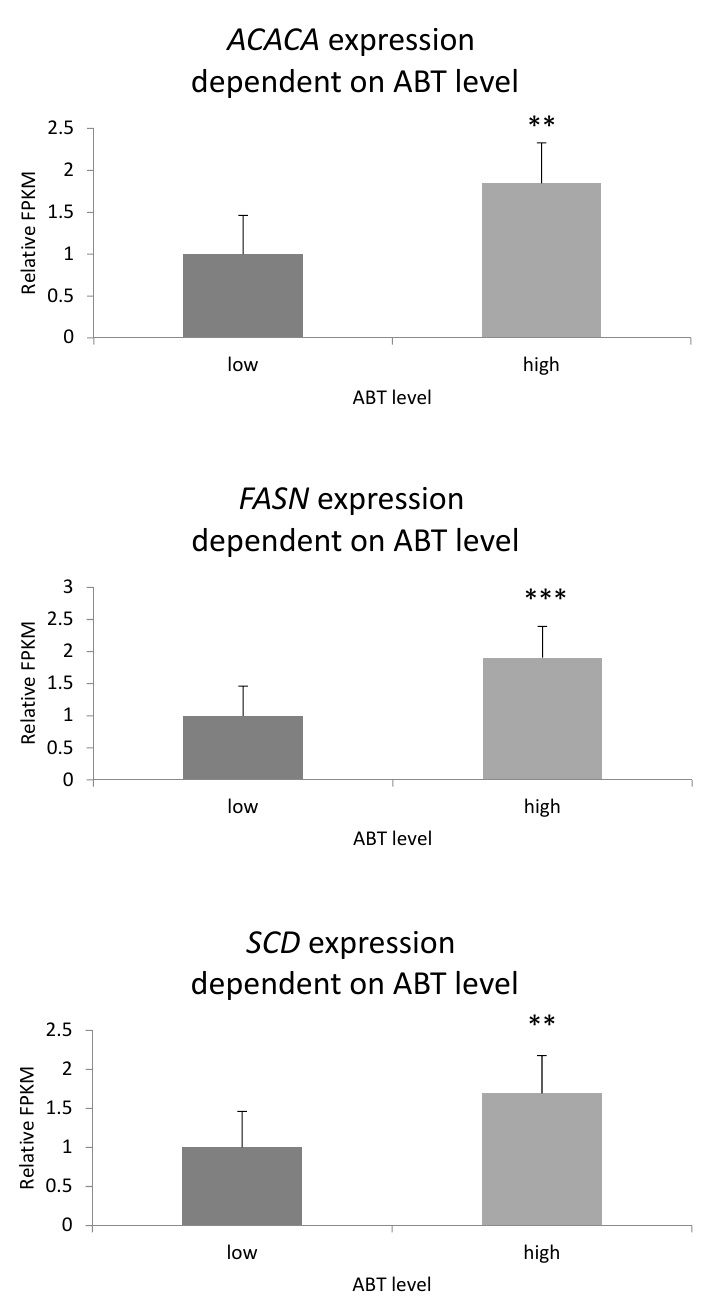
Figure 1. The FASN , SCD , and ACACA expression pattern in fat tissue for various backfat thickness values in the Puławska breed. The expression was estimated based on Fragments Per Kilobase of transcript per Million mapped reads (FPKM). ABT—average backfat